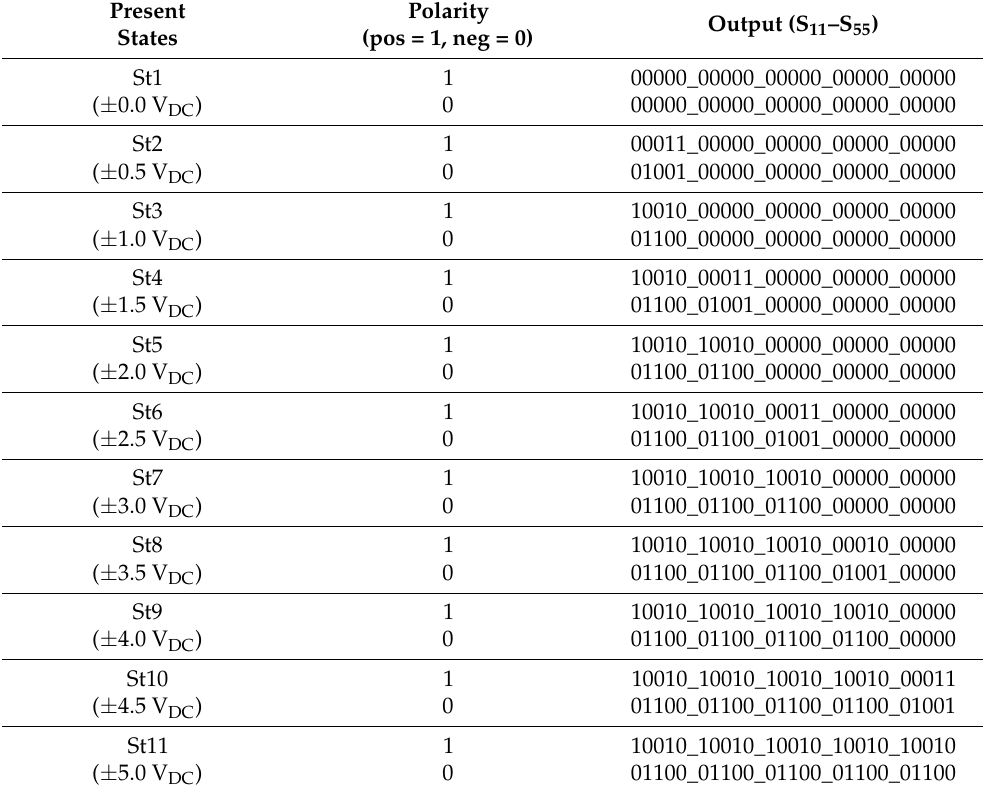
Table 5. Output gating patterns of the SHE digital switching controller (S 11 –S 55 ) for each